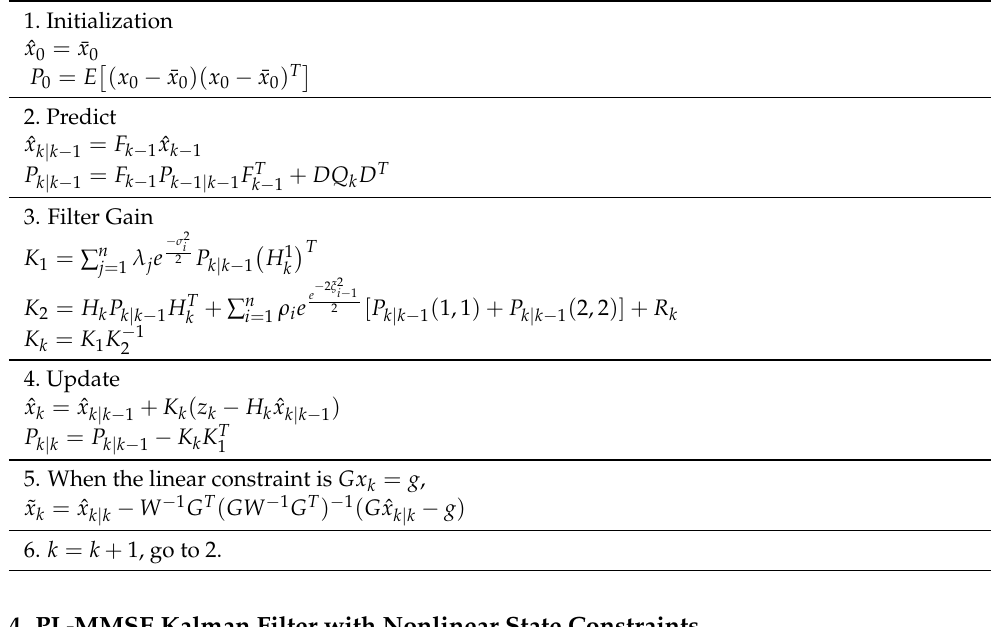
Table 2. PL-MMSE with Linear Constraints